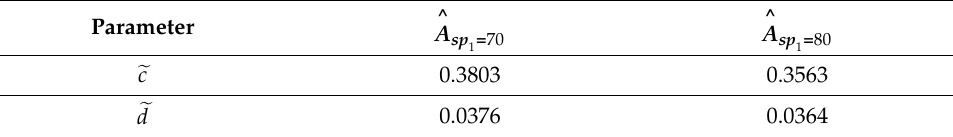
parameters’ values (procedure 1